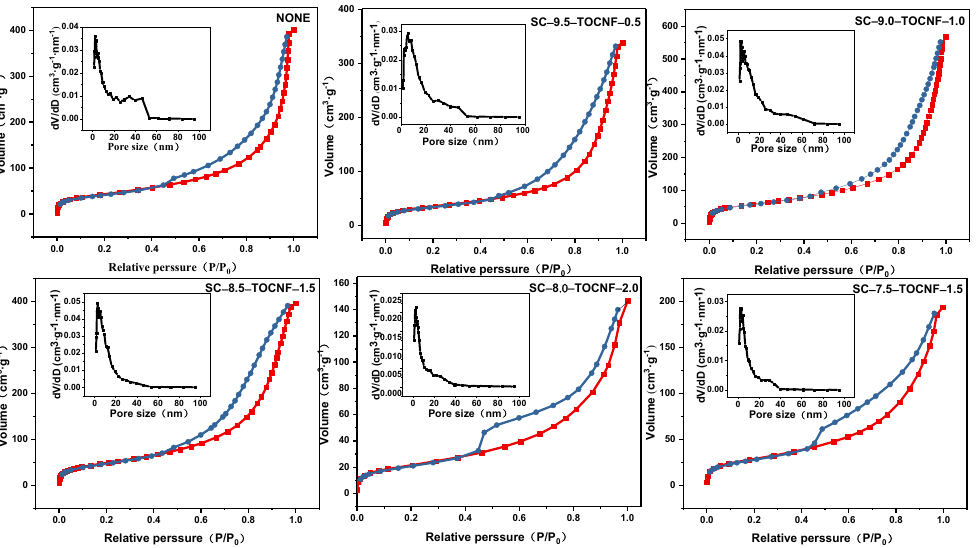
Figure 4. Brunner − Emmet − Teller measurements (BET) of aerogel spheres (samples were named as follows: Salix psammophila microcrystalline cellulose solution-mass of solution (g)- Salix psammophila nanofiber solution-mass of solution (g)). Table 1. BET specific surface, total pore volume, and average pore size of composite aerogel spheres. Sample